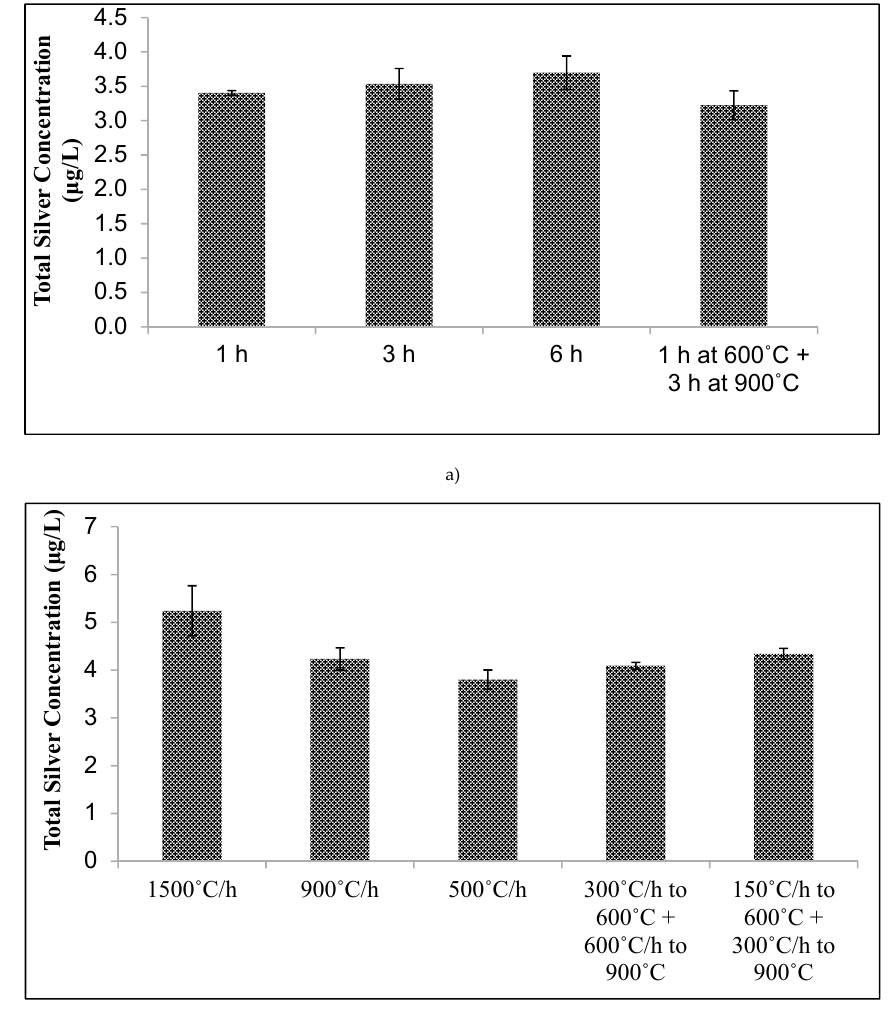
Figure 4. Total silver concentration in 10 L of tap water after 24 h as a function of ceramic tablet firing protocol. Each ceramic tablet contains 1 g of silver. Error bars represent standard error. Graph ( a